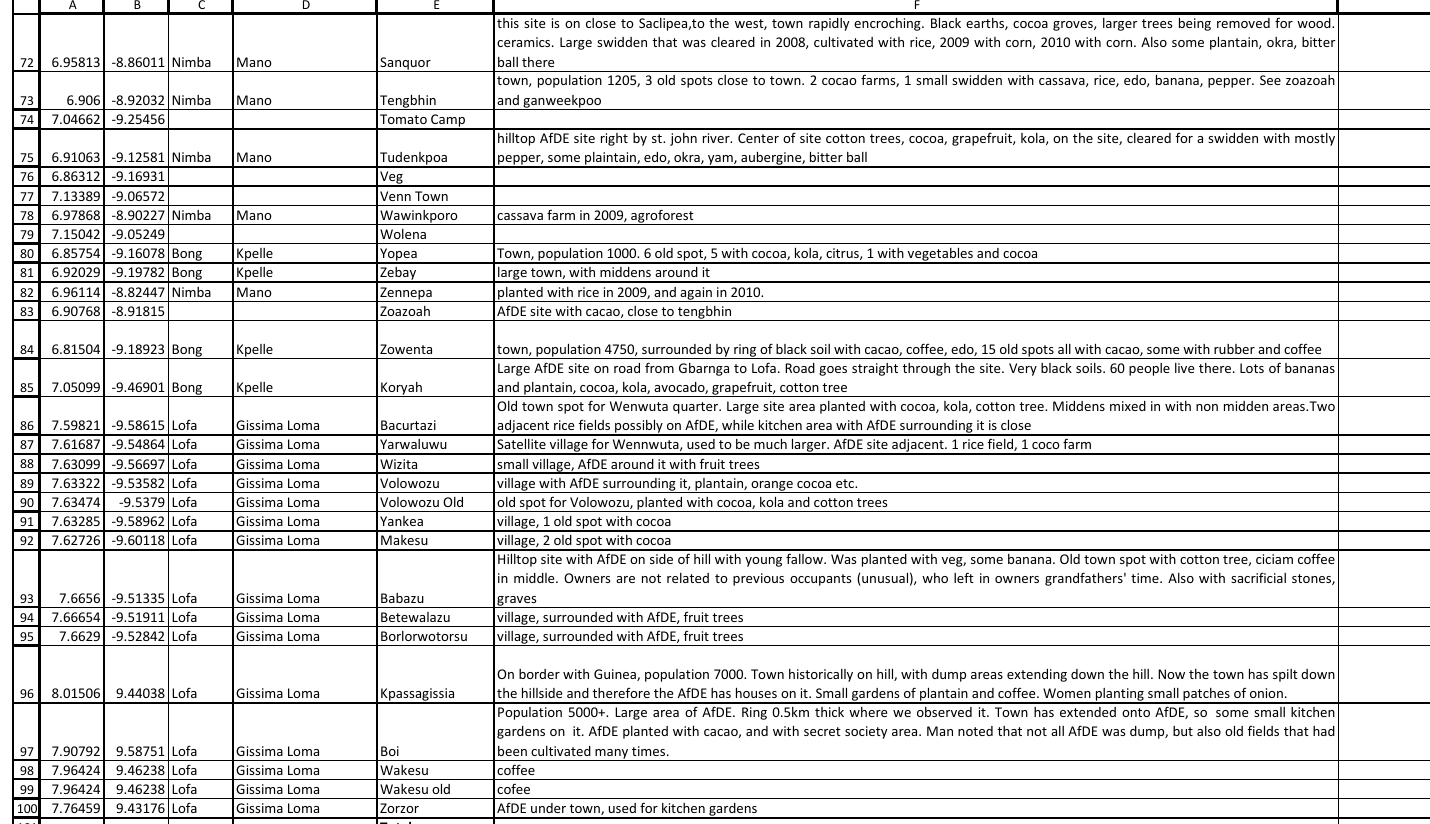
Population 5000+. Large area of AfDE. Ring 0.5km thick where we observed it. Town has extended onto AfDE, so some small kitchen gardens on it. AfDE planted with cacao,and with secret societyarea. Mannoted thatnot allAfDE wasdump,butalso oldfields thathad been cultivated many